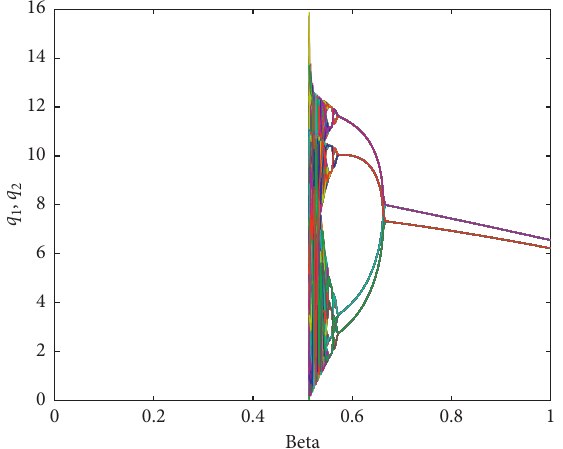
Figure 10: Bifurcation diagram for game (12) as a function of control parameter β when k � 1 .